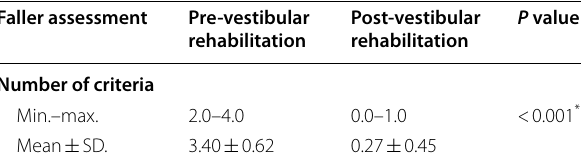
Table 16 Comparison of number of faller risk criteria before and after vestibular rehabilitation